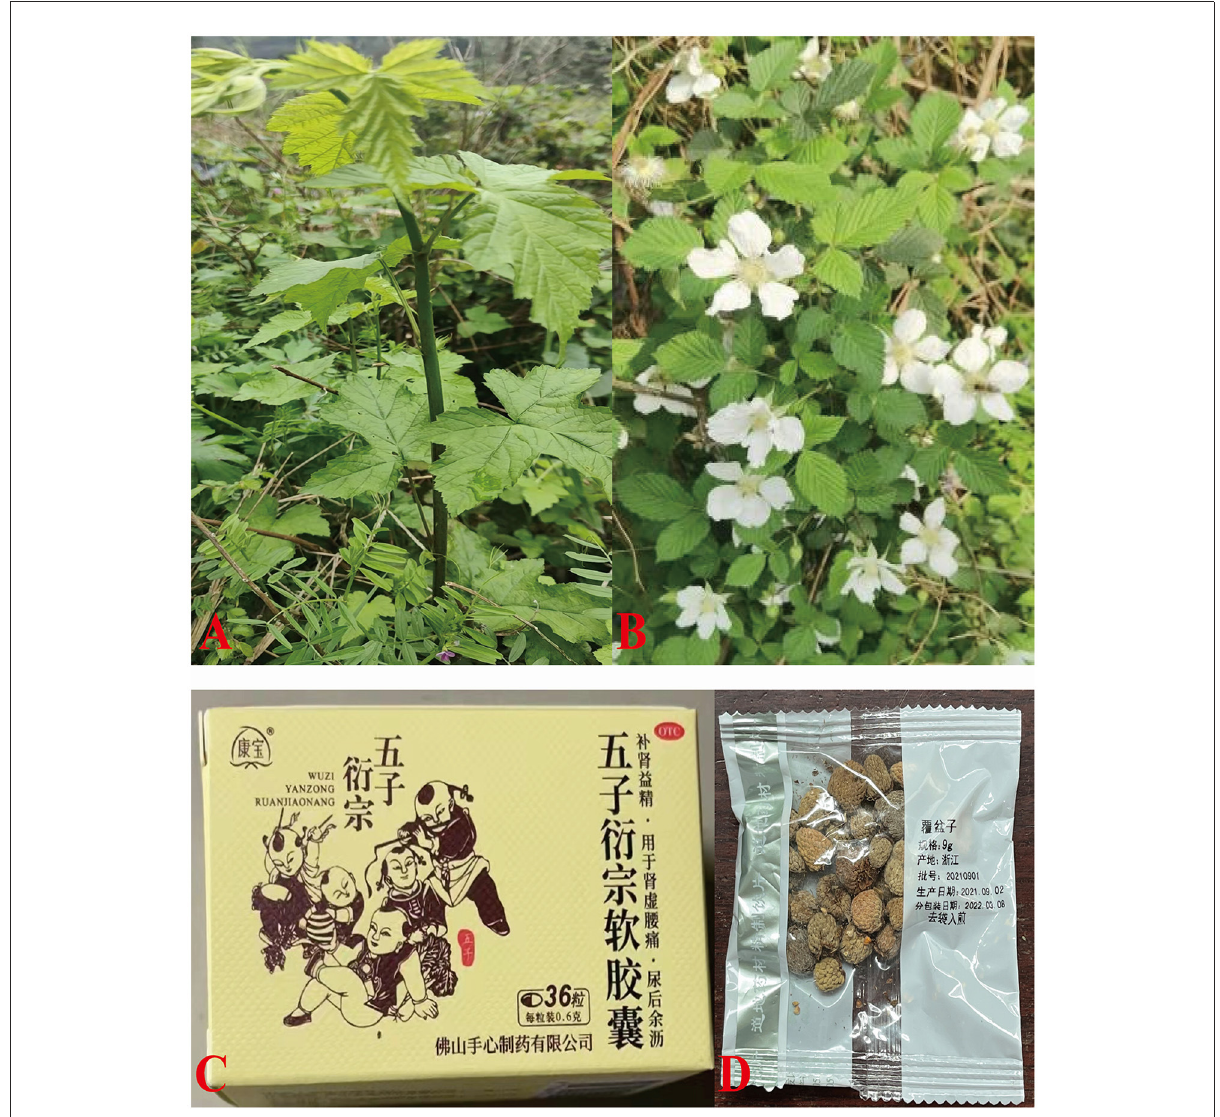
FIGURE1 Plant, flowers, dried fruitlet of R. chingii Hu (Fu-Pen-Zi) and related Chinese medicines. (A) Plant of R. chingii Hu, (B) Flowers, (C) WuziYanzong Pill, and (D) Dried fruitlet (Fu-Pen-Zi).